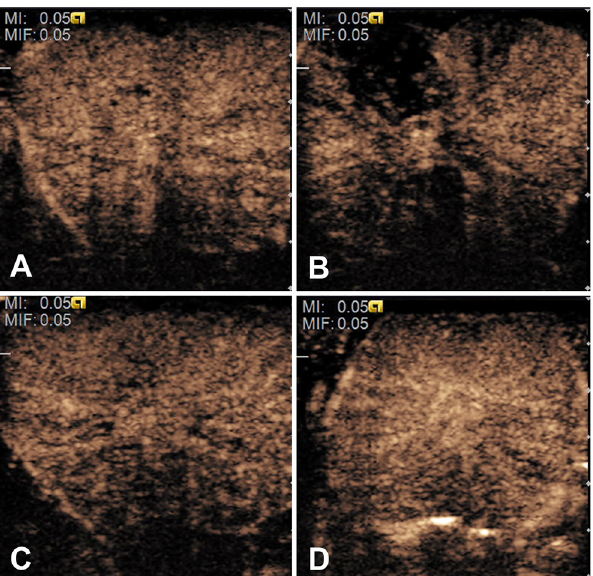
Fig 3. Contrast-enhanced ultrasound images of the microbubble-enhanced ultrasound and prothrombin and prothrombin-treated prostates. (B) The microbubble-enhanced ultrasound and prothrombin-treated prostate, demonstrating a significant blood perfusion decrease in the targeted area. (A, C, D) The baseline in the microbubble-enhanced ultrasound and prothrombin group (A) and all of the corresponding contrast-enhanced ultrasound images (C: before treatment, D: after treatment) of the prothrombin-treated prostates, showing homogenous blood perfusion.